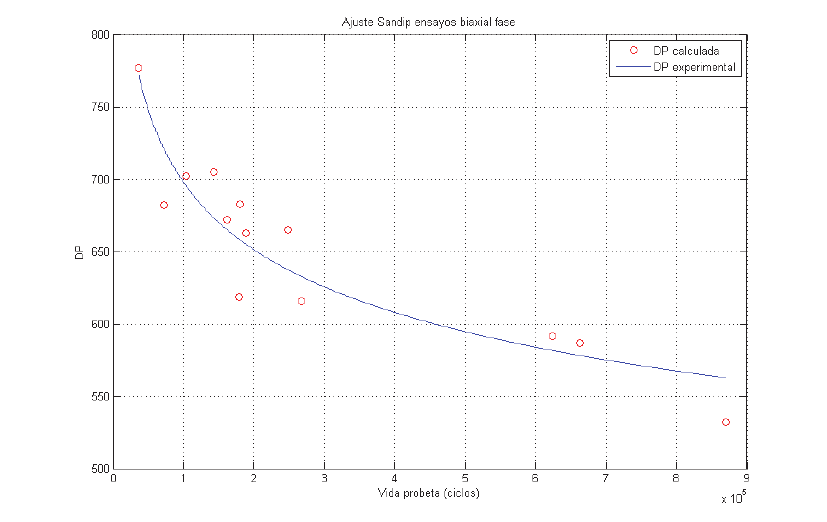
Figure 5: Fatigue life correlation for St52-3N steel based on Sandip model (k=2.1,